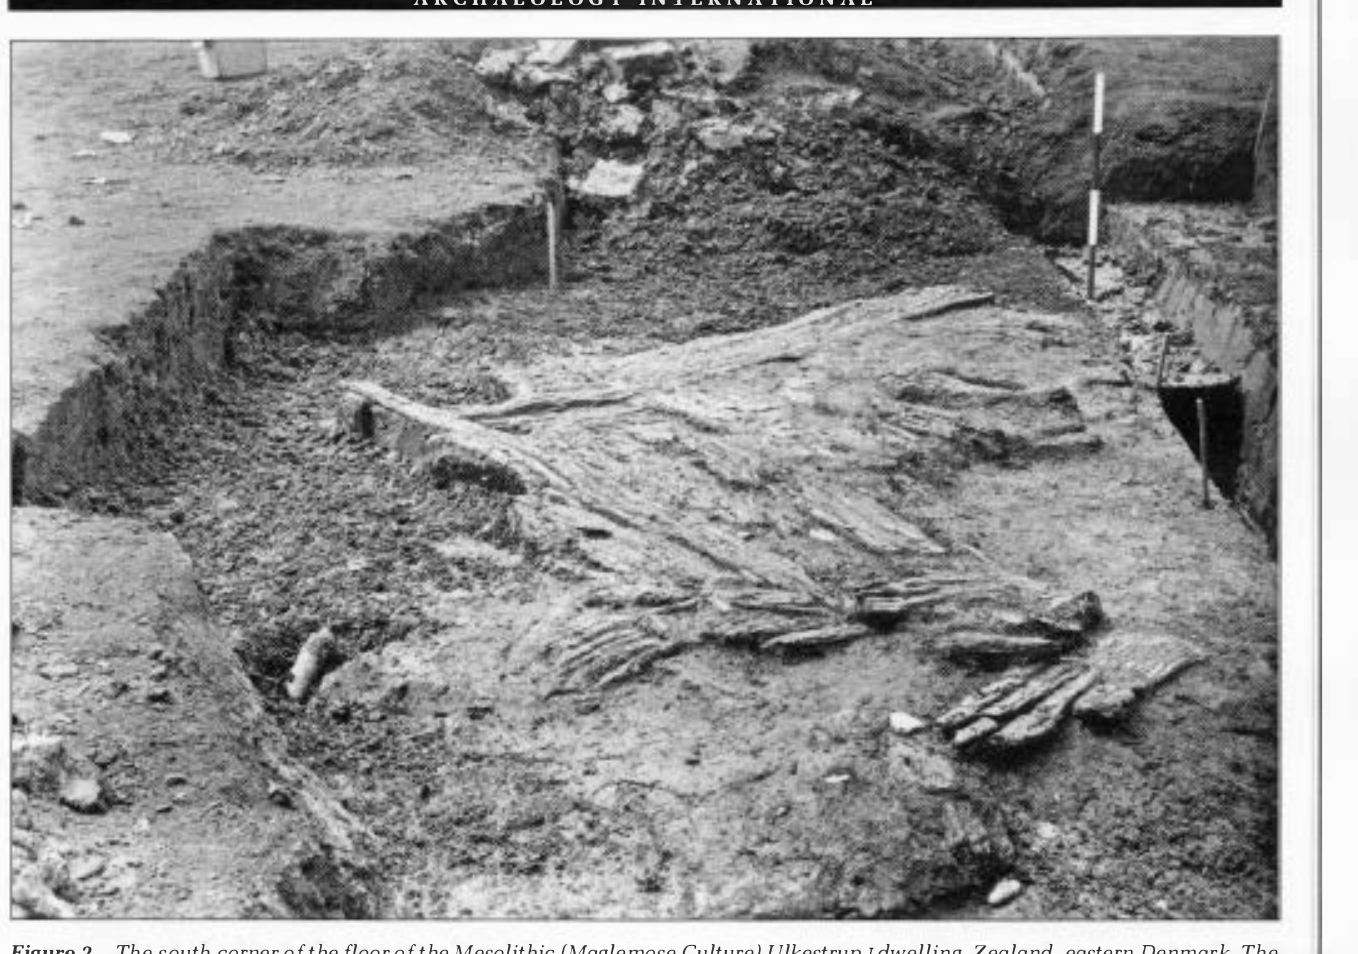
Figure 2 The south corner of the floor of the Mesolithic (Maglemose Culture) Ulkestrup I dwelling, Zealand, eastern Denmark. The floor consisted of bark and bundles of branches with large quantities of flint tools and debitage on it and two hearths. It was excavated in a peat bog in 1 947 and dates to the seventh millennium BC.